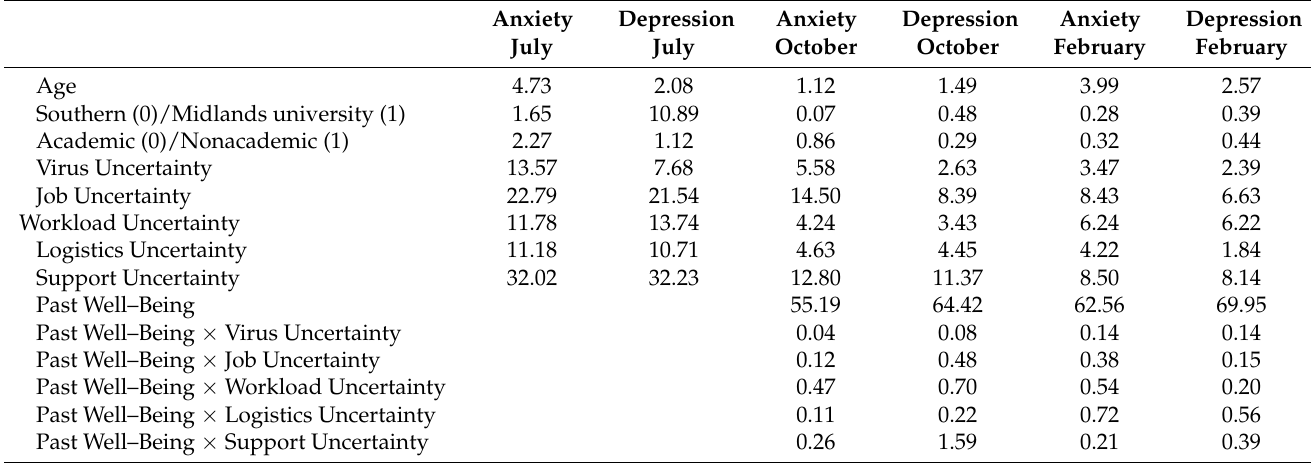
Table 7. Relative Weight Analysis of uncertainty on